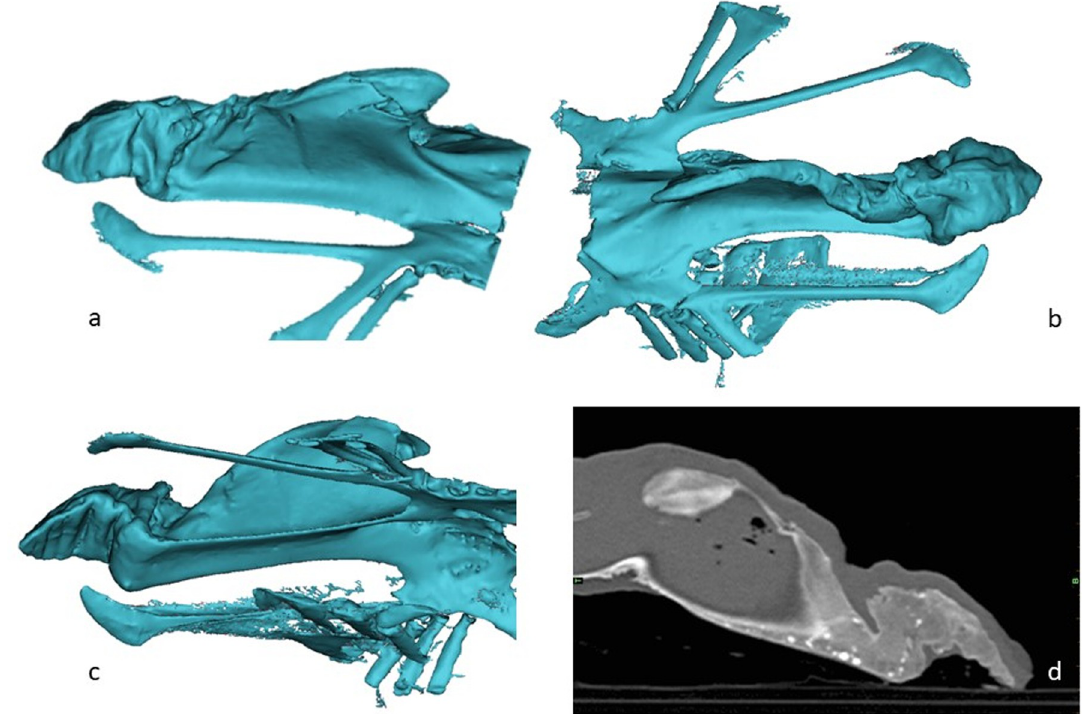
Fig 7. 3D reconstruction (a,b,c,) and CT image (d) of a 75-week hen showing multiple fractures. Notice the radioopaque spots in the CT